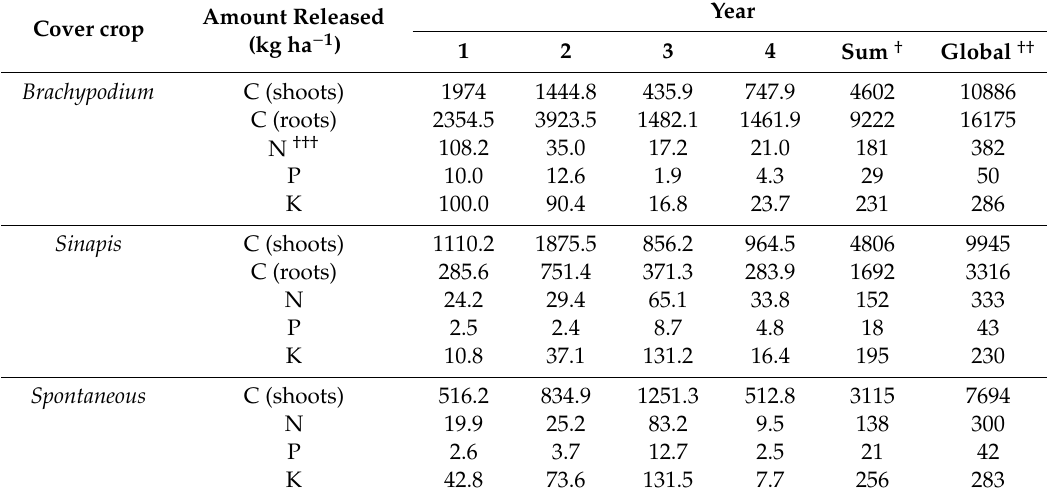
Table 6. Amount released per cover crop and year, and total amount released along the decomposition cycles and the whole field